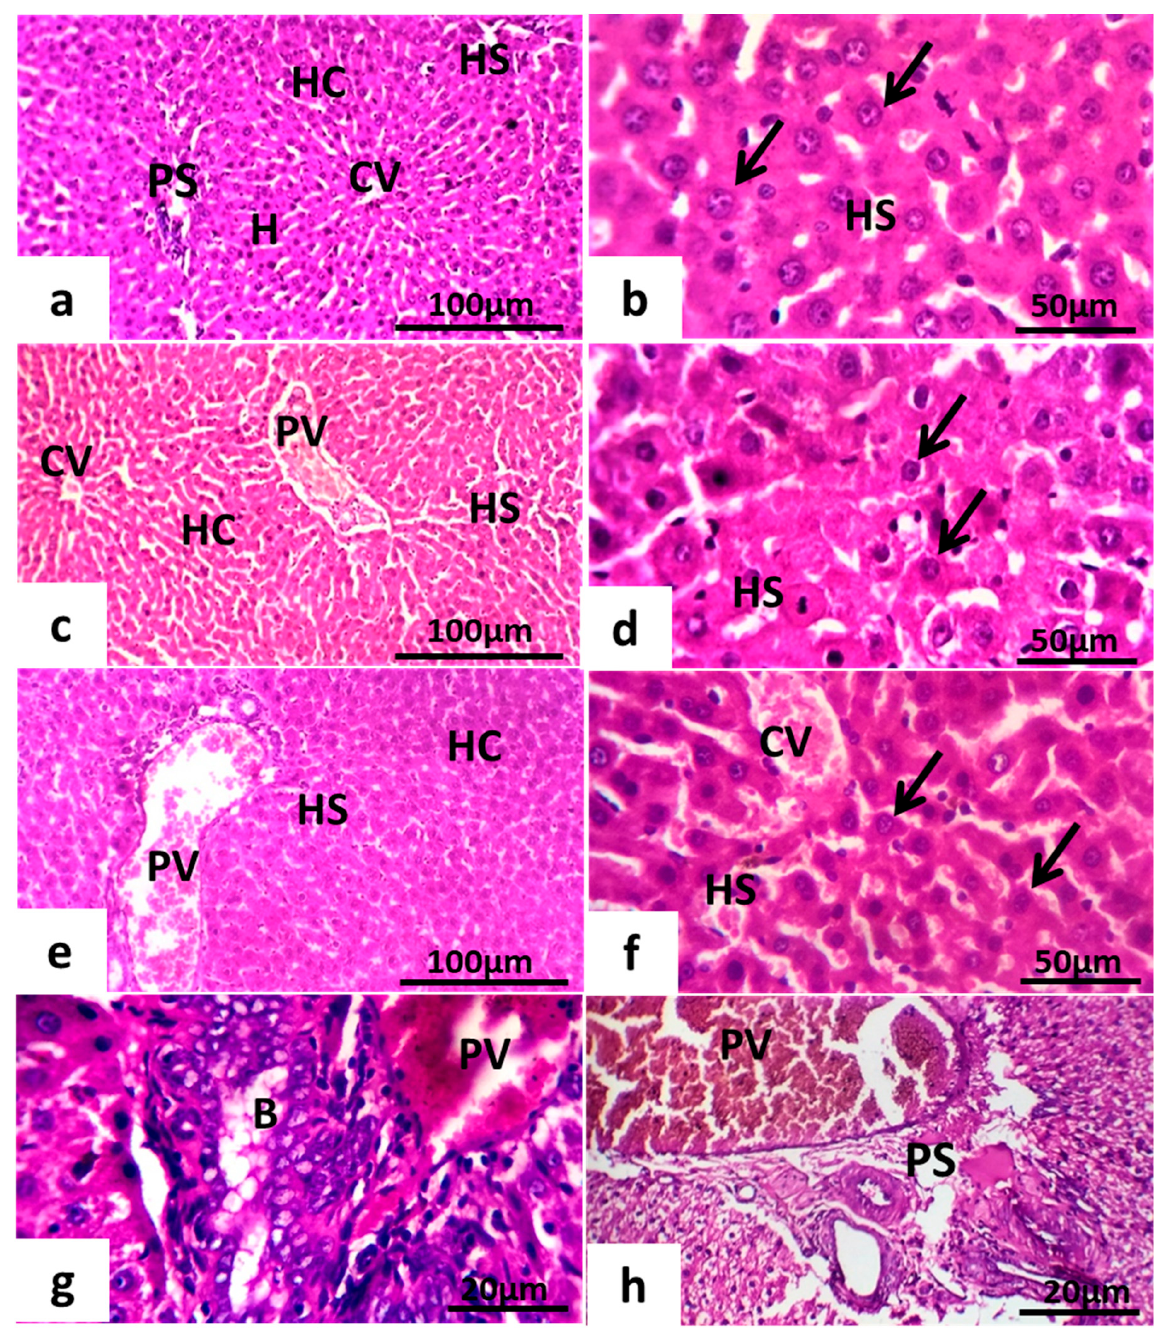
Figure 8. Photomicrograph of maternal rats’ liver. ( a , b ) Normal control group. ( c , d ) treated females at (0–7th dpc). ( e , f ) treated female at (7–14th dpc). ( g , h ) treated female at (0–20th dpc). Notice the portal space (PS), portal vein (PV), central vein (CV), hepatocytes (HC, arrows) of hepatic strands (H), and hepatic sinusoids (HS). H&E.